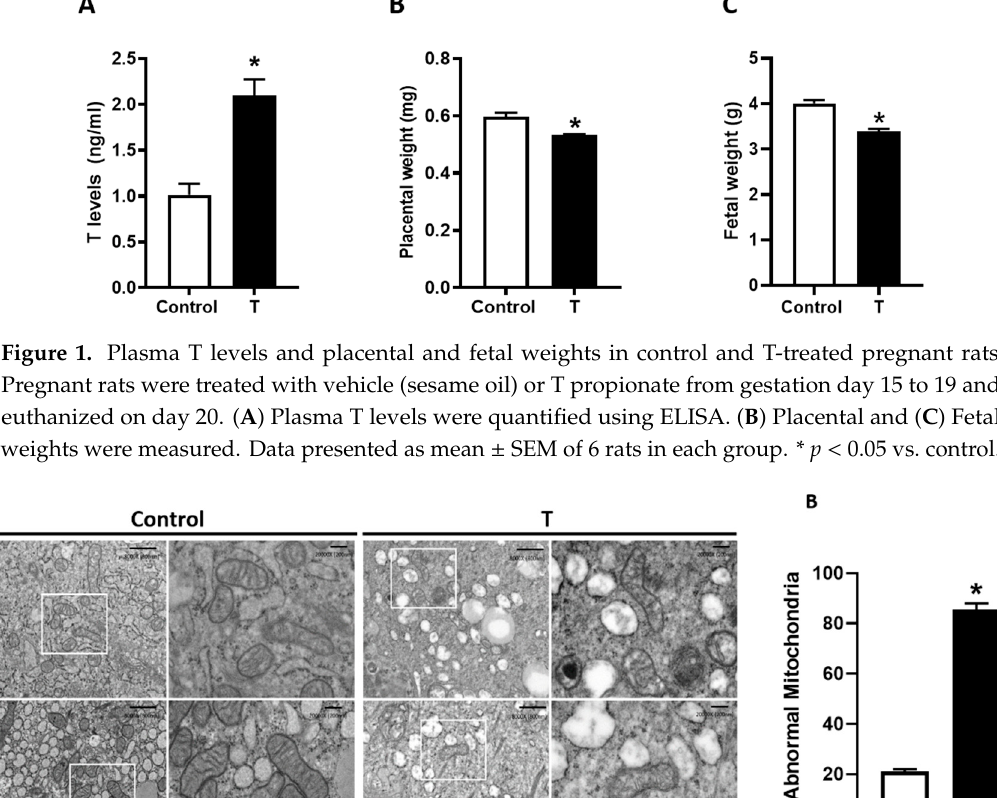
Figure 1. Plasma T levels and placental and fetal weights in control and T-treated pregnant rats. Pregnant rats were treated with vehicle (sesame oil) or T propionate from gestation day 15 to 19 and euthanized on day 20. ( A ) Plasma T levels were quantified using ELISA. ( B ) Placental and ( C ) Fetal weights were measured. Data presented as mean ± SEM of 6 rats in each group. * p < 0.05 vs. control.